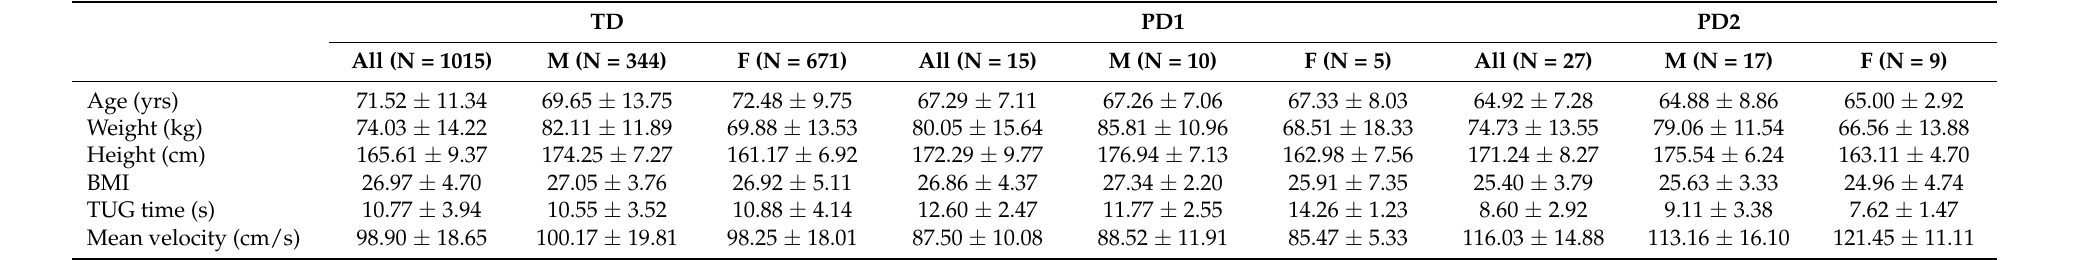
Table A1. Anthropomorphic and clinical data separated by gender for each